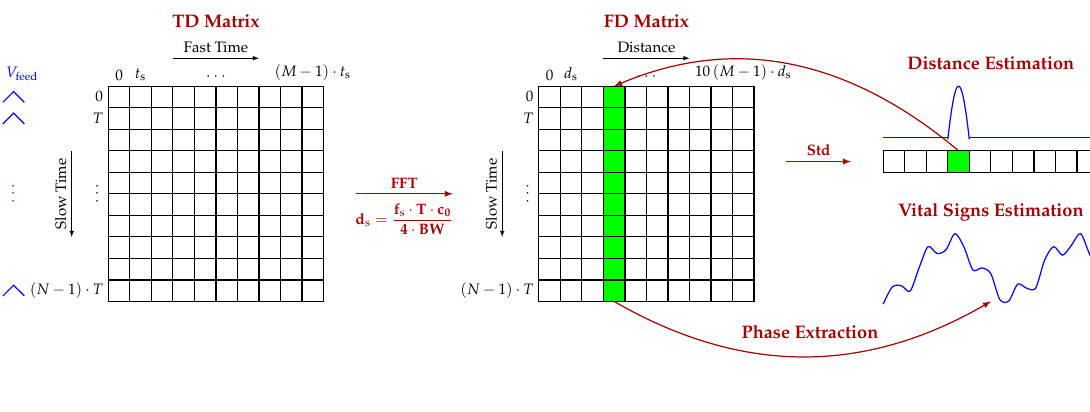
Figure 5. Signal processing chain: TD matrix, FD matrix resulting from the fast Fourier transform (FFT), standard deviation (std) array for the distance estimation, and phase extraction for the vital signs’